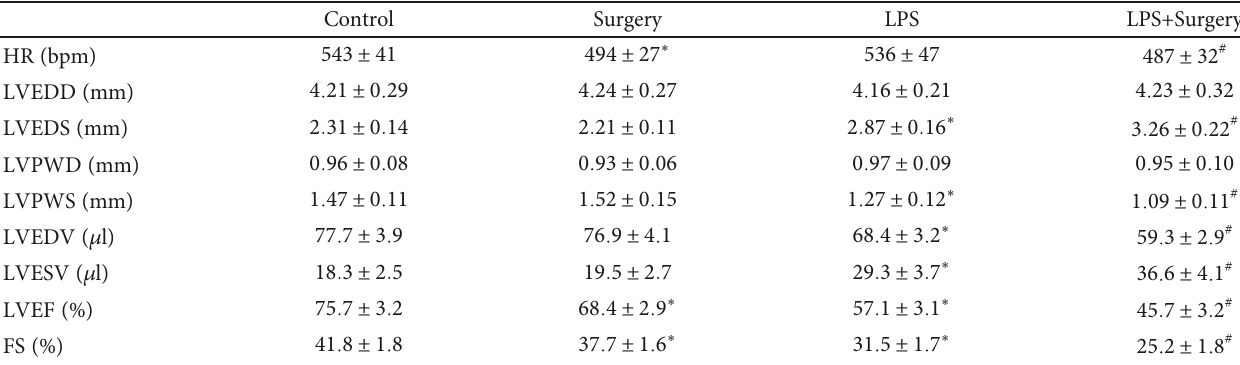
Table 2: E ff ects of thyroidectomy on cardiac function in LPS-treated mice. Control Surgery LPS